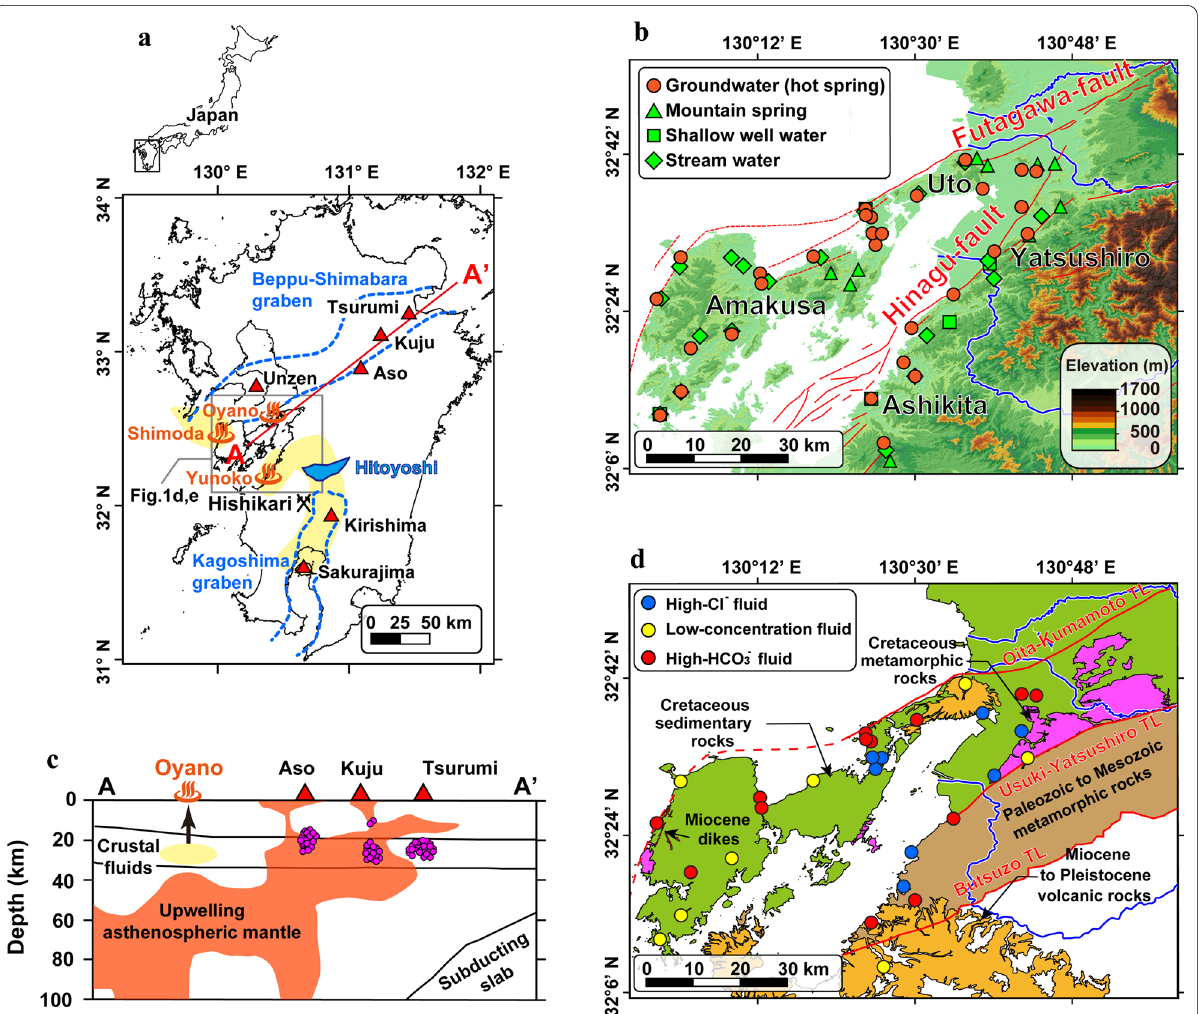
Fig. 1 Map showing the study area and its geological background. a Tectonic structure of the Kyushu Islands with location of active volcanoes (red triangle) and some important localities explained in the main text. The Beppu–Shimabara and Kagoshima grabens are after Matsumoto (1979) and Hayasaka (1987). Yellow hatch indicates an area, where subsurface high conductivity blocks distribute in and beneath lower crust which were depicted from recent electrical resistivity survey (Hata et al. 2017). b Sampling locations shown on topographical map with locality name and major fault systems. c A–A’ cross section in panel a showing the locations of low frequency micro earthquakes during 2002–2016 (purple circles) and low seismic velocity zones (red color) in the mantle wedge and crust (Zhao et al. 2018). d Simplified geological map modified after Moreno et al. (2016). Geographical distribution of three types of fluids, High-Cl − , Low-concentration and High-HCO 3 − fluids, are also